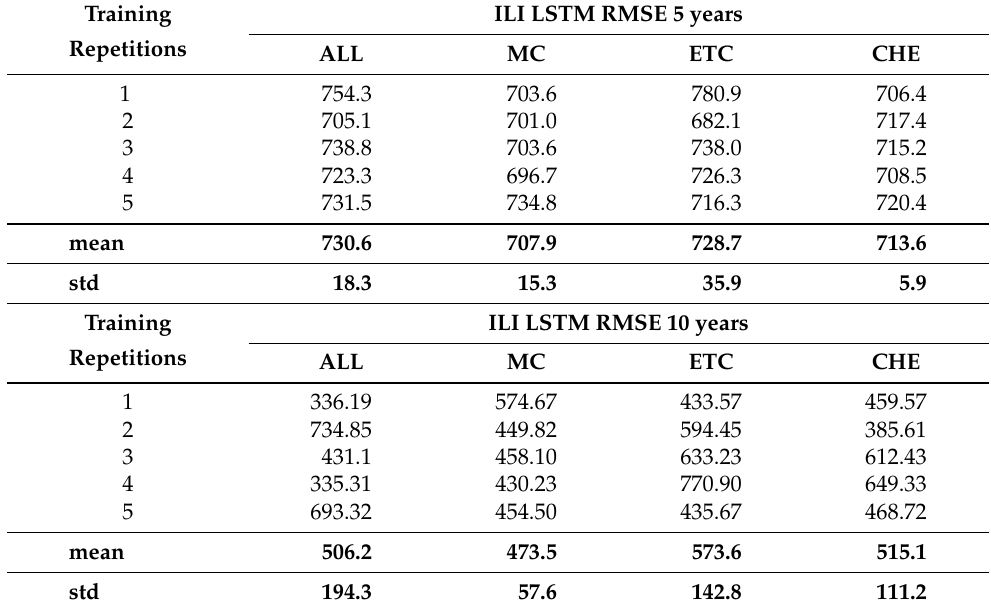
Table 6. ILI RMSE using 5 and 10 years data.